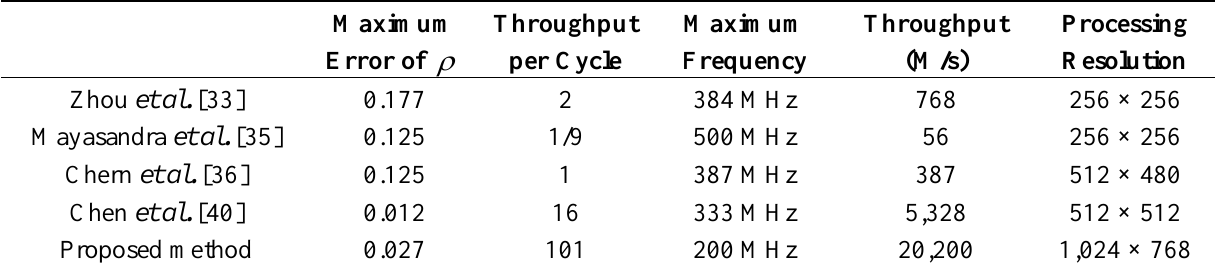
Table 1. Performance comparison among different